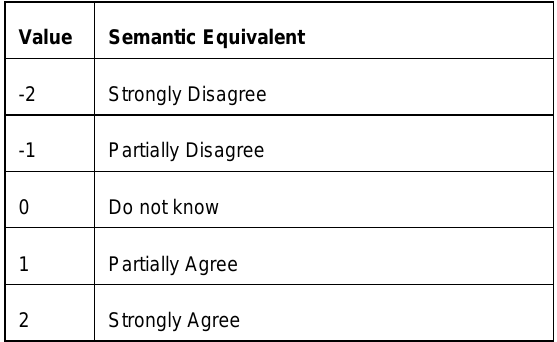
Table 3. CSI-NAP v. 0.3: Likert scale and